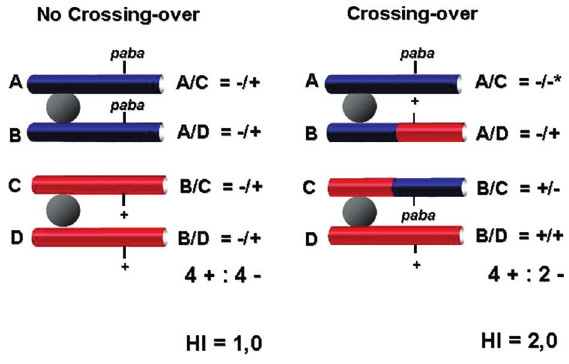
Figure 2 - Origin of heterozygous (+/- and -/+) and homozygous (+/+) diploids caused by mitotic crossing-over between paba gene and centromere. (*) Do not grow in MM (Pires and Zucchi 1994).